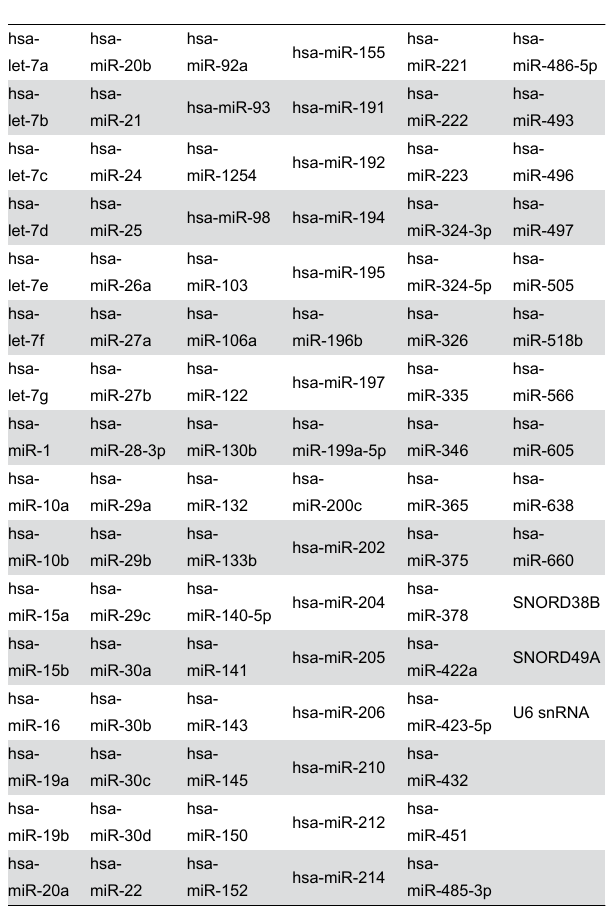
(one with carcinoid and one with sarcomatoid tumors), who served as additional controls. The lung SCC group included